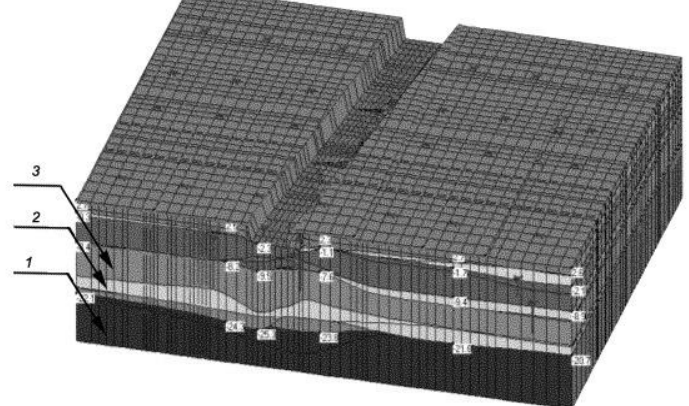
Figure 1. Location of aquifers [2].